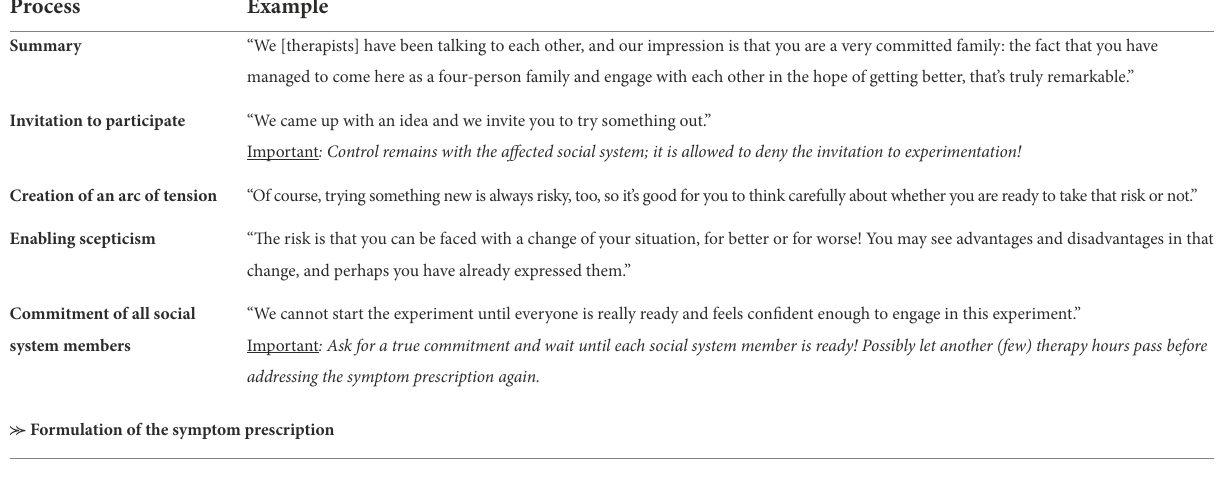
TABLE 8 Closing commentary introducing a symptom prescription (Schweitzer et al., 2020). Process